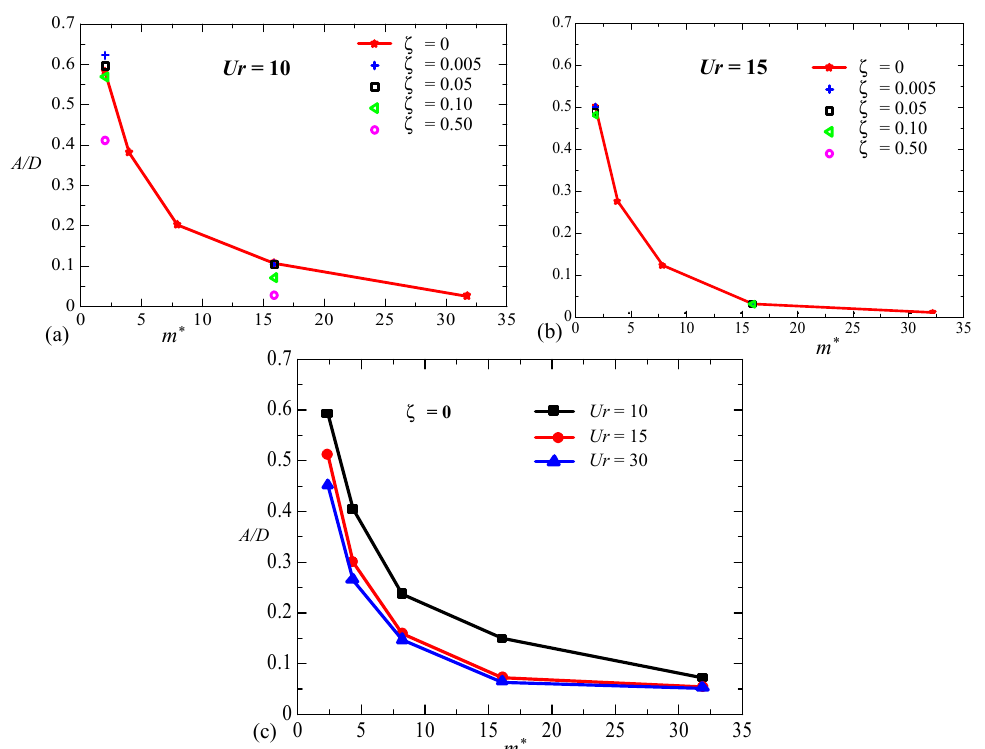
Figure 9. Effect of mass ratio m * on vibration amplitude A/D at different ζ and Ur values when ( a ) Ur = 10, ( b ) Ur = 10 and ( c ) ζ = 0. L/D = 1.5.